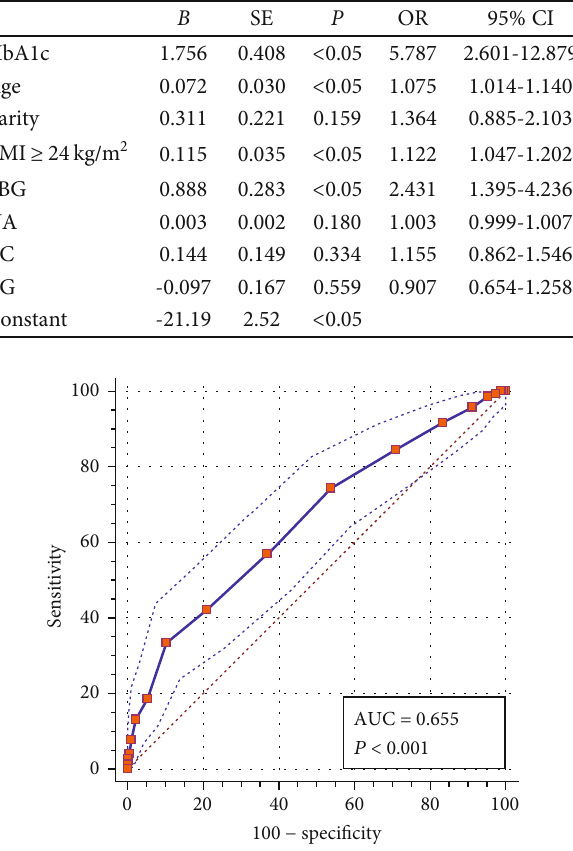
Table 2: Logistic regression analysis of in fl uencing factors of GDM.